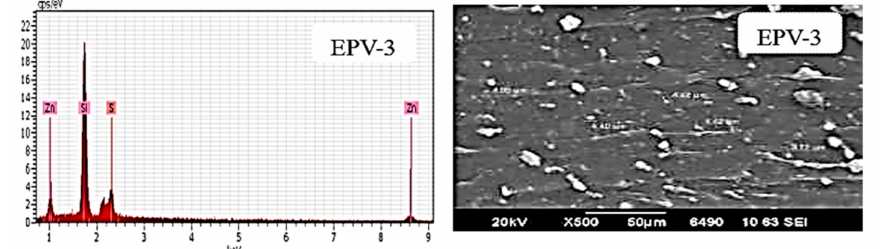
Figure 3. EDS spectra and SEM images of samples with Vulkasil-C as filler (phase-1).